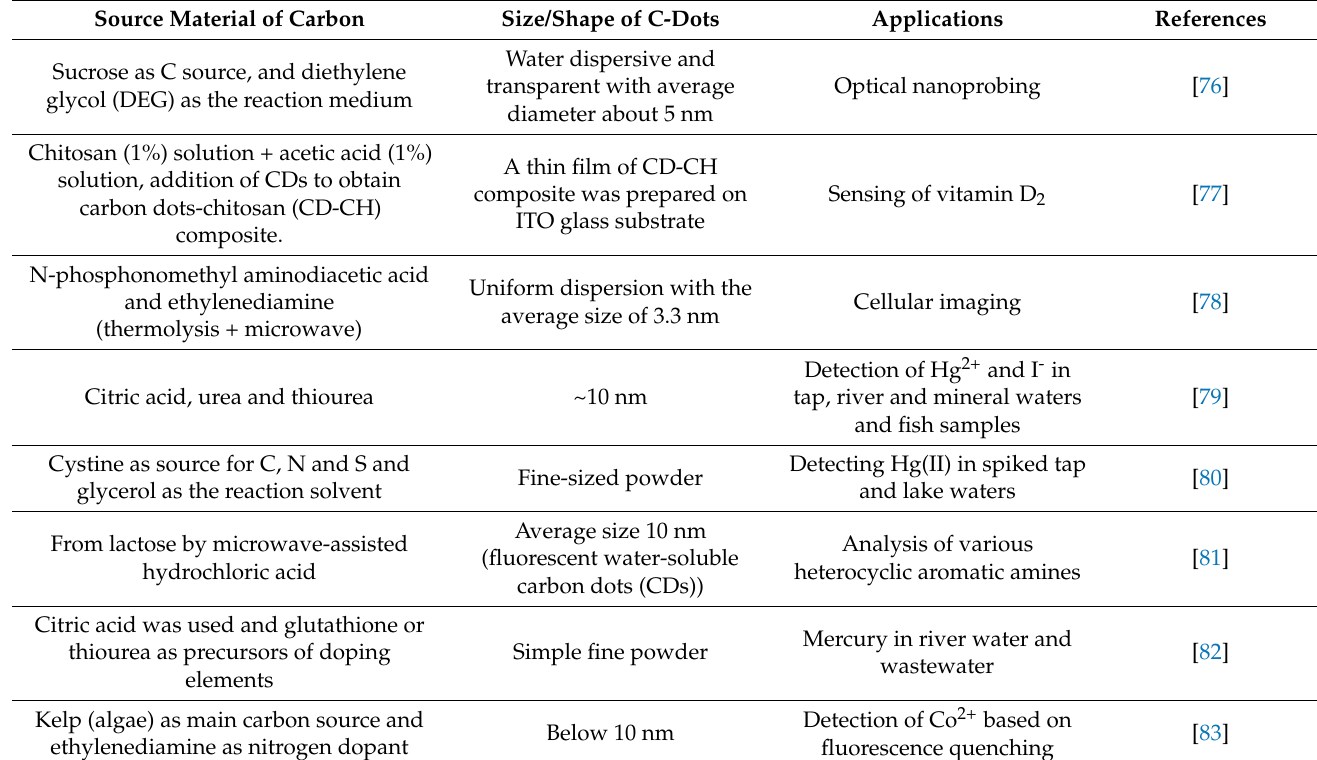
Table 4. Microwave-assisted synthesis of